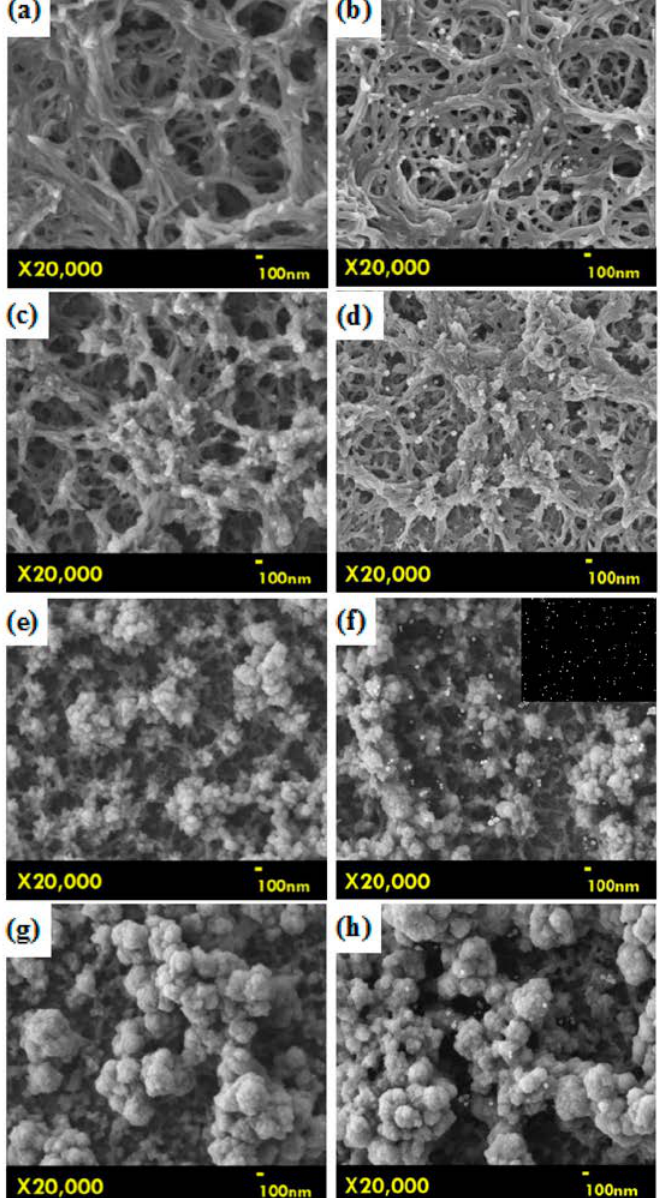
Figure 5. SEM images of ( a ) PICA; ( b ) PICA-Pt; ( c ) P(ICA4- co -EDOT1); ( d ) P(ICA4- co -EDOT1)-Pt; ( e ) P(ICA3- co -EDOT2); ( f ) P(ICA3- co -EDOT2)-Pt; ( g ) P(ICA2- co -EDOT3); and ( h ) P(ICA2- co -EDOT3)-Pt composite films; inset in ( f ) is X-ray map (bright spots indicate